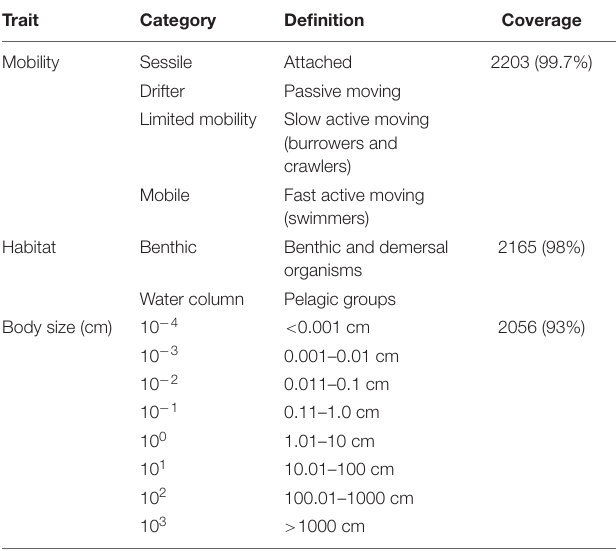
TABLE 2 | List of categorical traits (mobility, habitat, and size), categories used, definitions, and data coverage of the data set ( n =